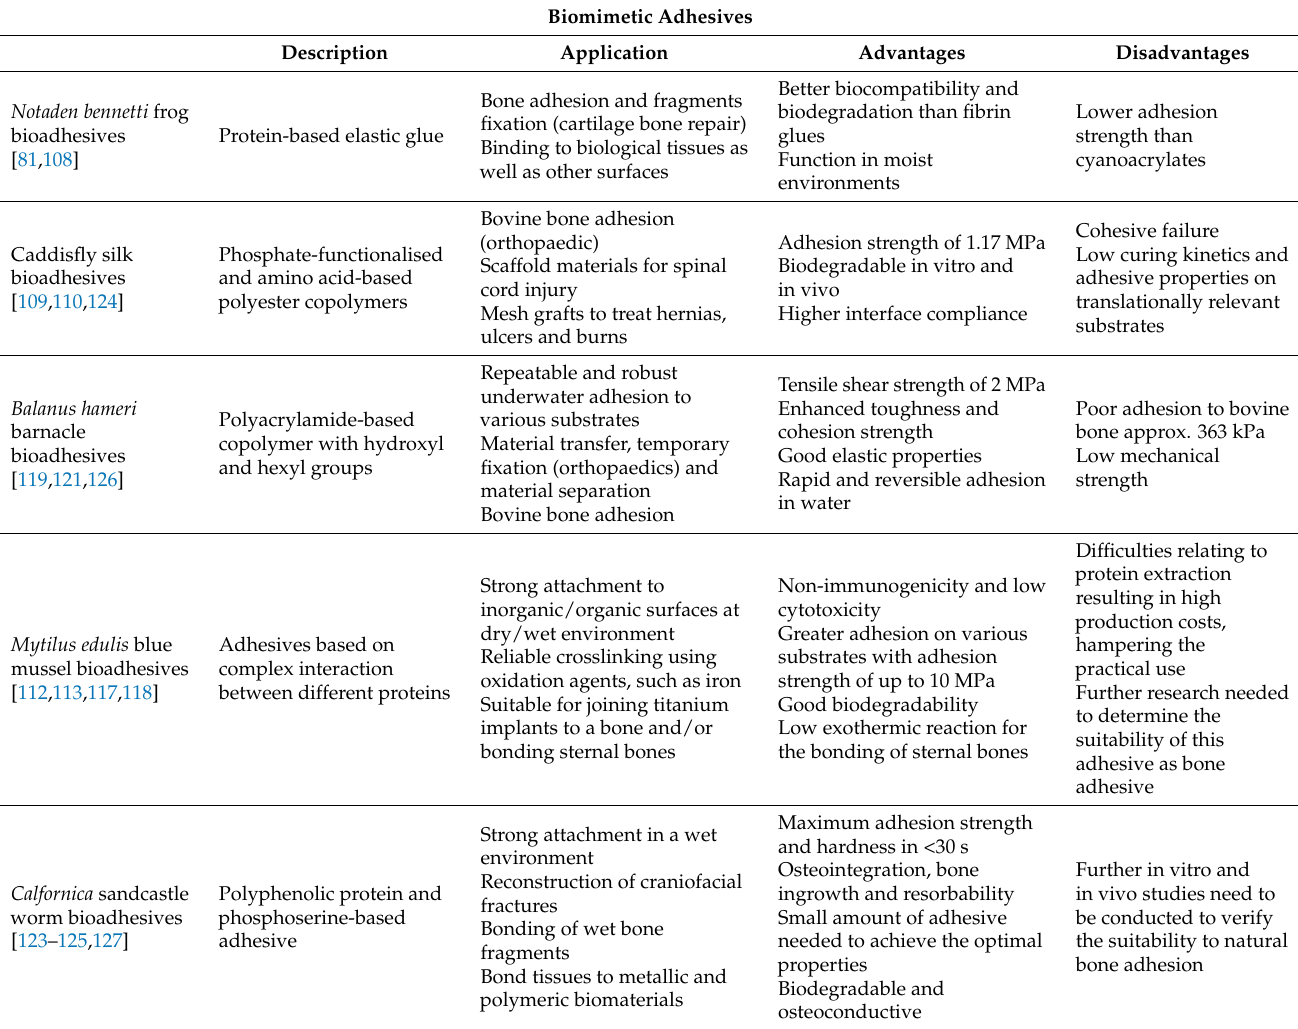
Table 2. Comparison of the different natural-based